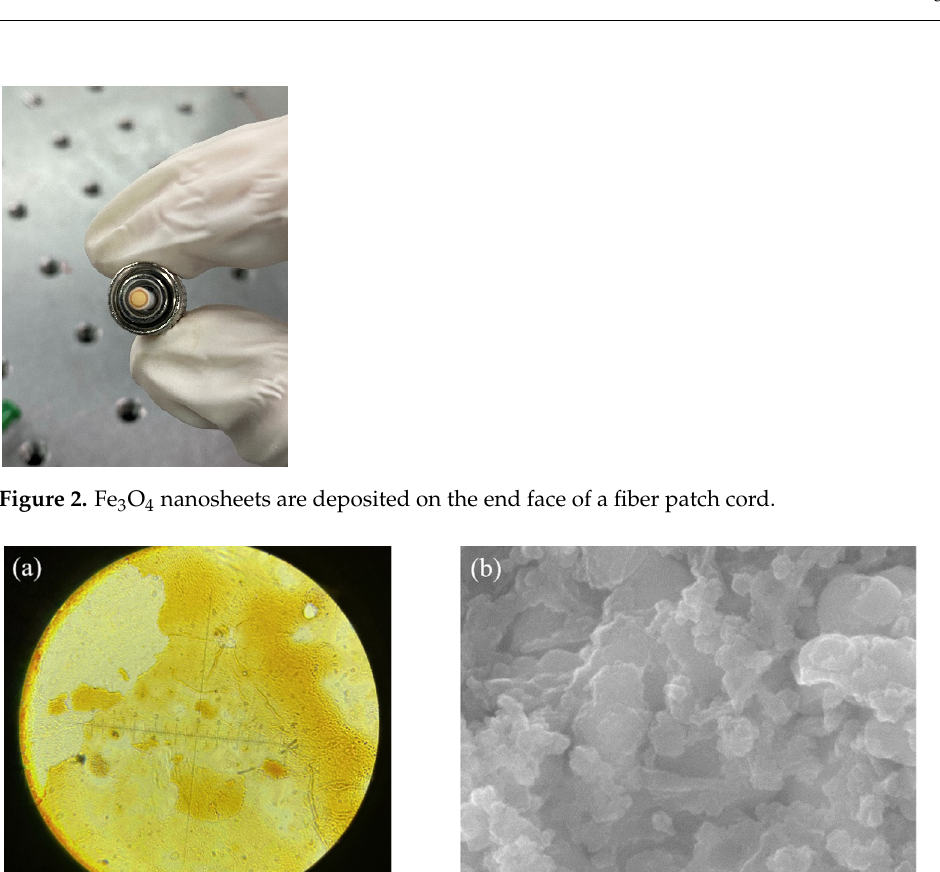
Figure 3. Surface morphology of Fe 3 O 4 nanosheets. ( a ) Fe 3 O 4 nanosheets under a 25 × 10 optical microscope and ( b ) the SEM image of Fe 3 O 4 at 100 nm scale.